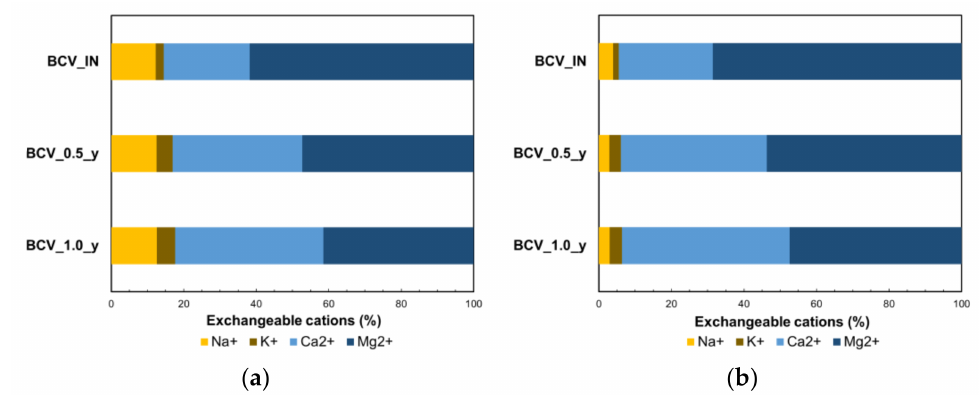
Figure 4. Exchangeable cations displaced by Cu-trien ( a ) and corrected by aqueous leachable cations ( b ).